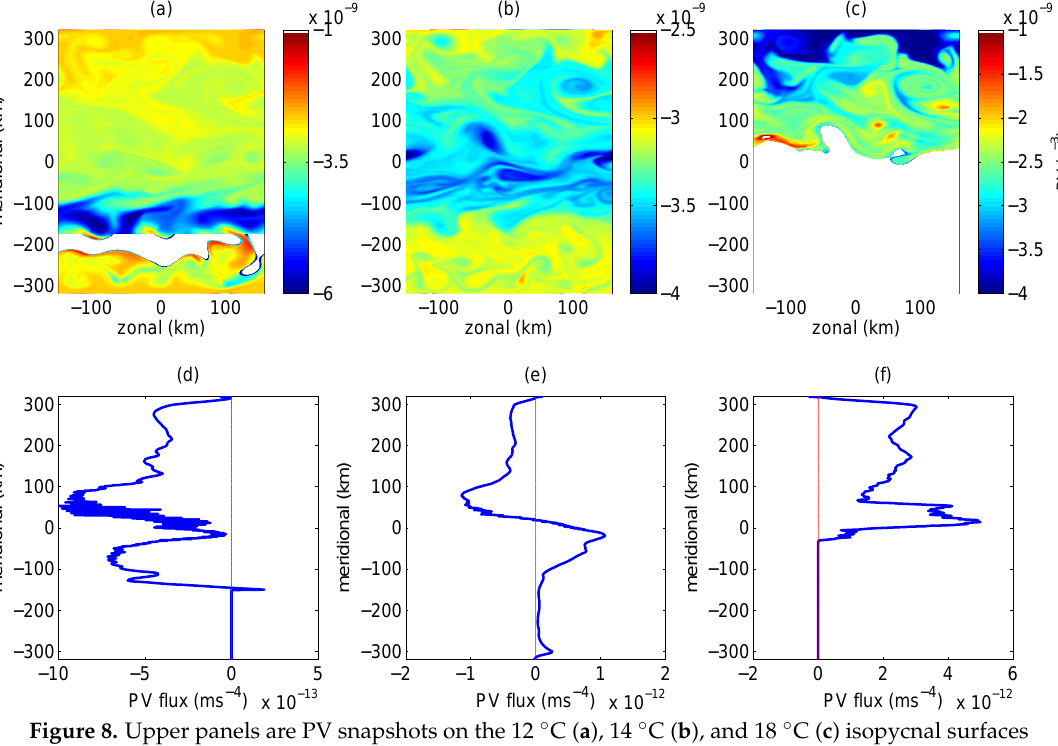
Figure 8. Upper panels are PV snapshots on the 12 ◦ C ( a ), 14 ◦ C ( b ), and 18 ◦ C ( c ) isopycnal surfaces at day 900 for Experiment DF-S. White areas indicate the isopycnal surface intersecting with the topographic slope or the surface. Lower panels ( d – f ) are the corresponding time and zonal averaged PV fluxes. PV fluxes are calculated using snapshots between day 800 and